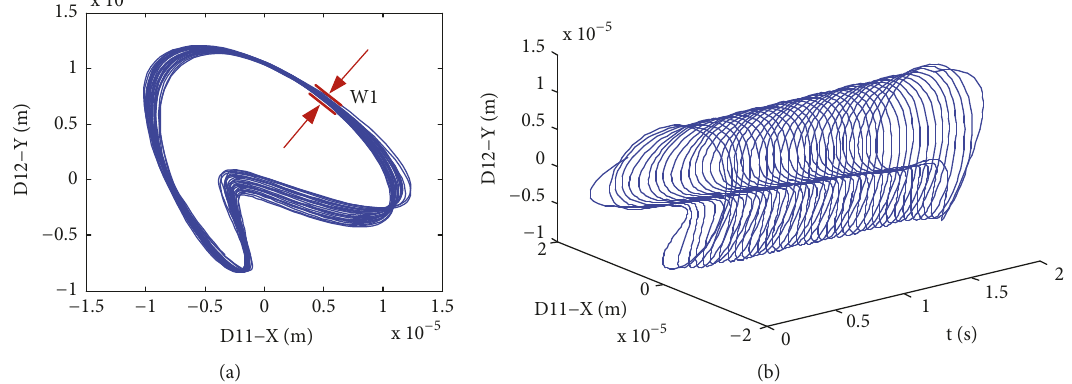
Figure 13: The synthesis of axis orbit is to extract the first two times fundamental frequencies of the D11 and D12 signals by the CFSM-PCA. (a) The axis orbit. (b) Relationship between axis orbit and